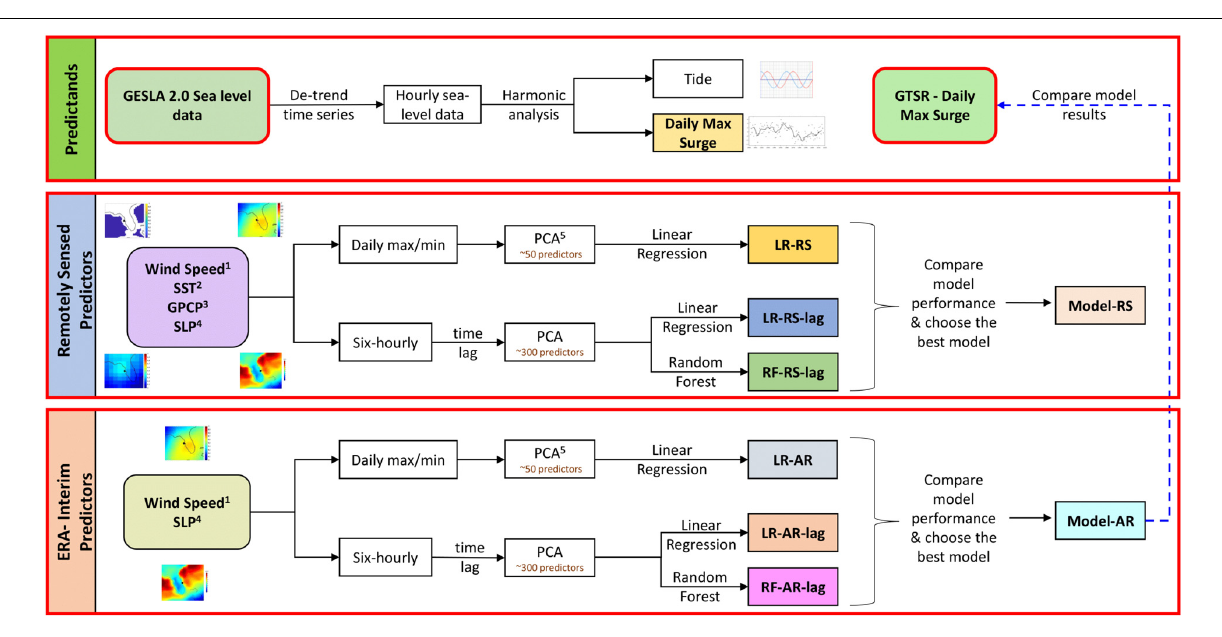
FIGURE 2 | Framework outlining the applied methodology to develop data driven storm surge models using different predictor data sets, and comparison with numerical model output. Key: wind speed1, zonal and meridional wind speed; SST2, sea surface temperature; GPCP3, Global Precipitation Climatology Project; SLP4, mean sea-level pressure; PCA5, principal component